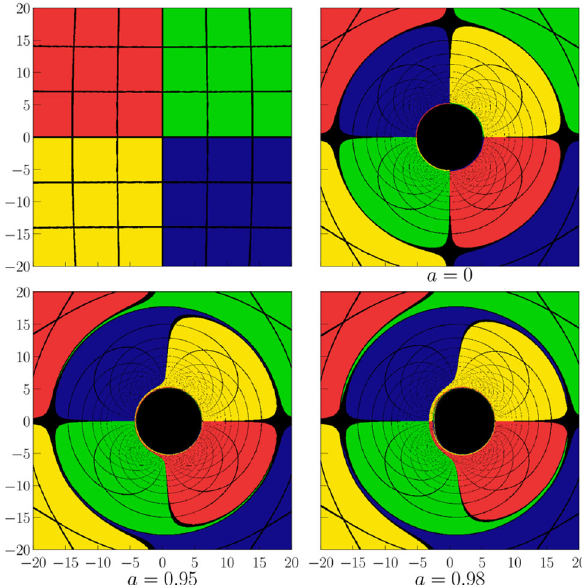
Fig. 12 Gravitational lens produced by a black Kerr hole, in Boyer- Lindquist coordinates, seen from the equatorial plane at a distance r = 100 and located at φ = 0. From left to right: in the top row, the Minkowski and Schwarzschild ( a = 0) space-time are shown; in the bottom row, a Kerr black hole with rotation a = 0 . 5 and a = 0 .